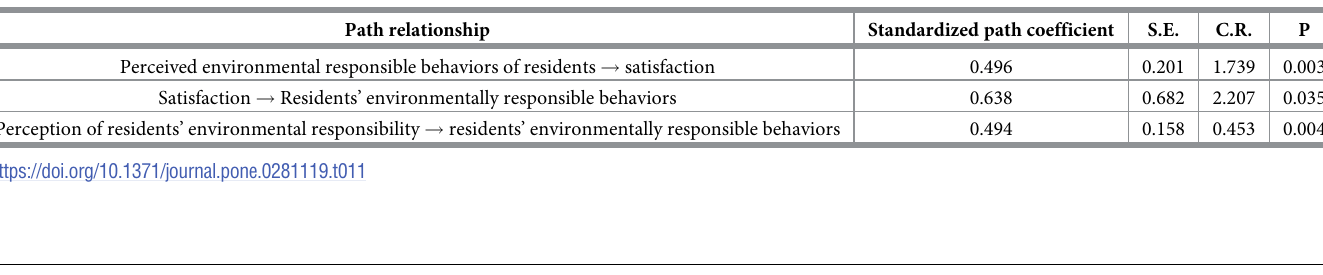
Table 11. Resident model path